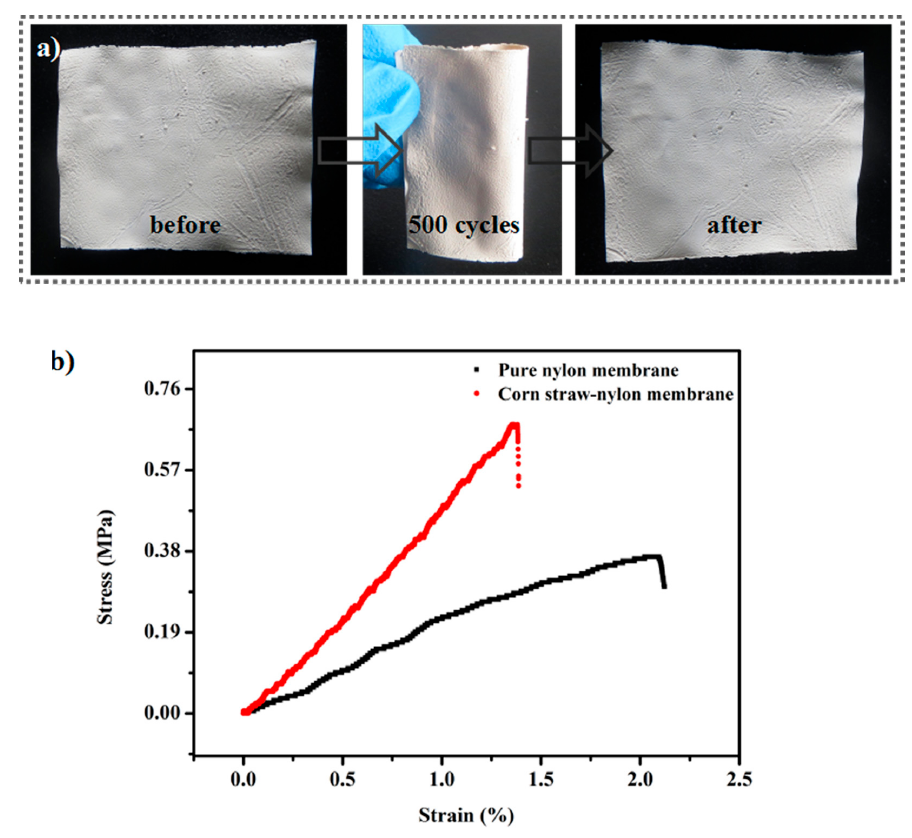
Figure 3. ( a ) Optical images of CSPNM before and after being bent over 500 times; ( b ) stress–strain curves of the PNM (pristine nylon 6,6 membrane) and the CSPNM, respectively.